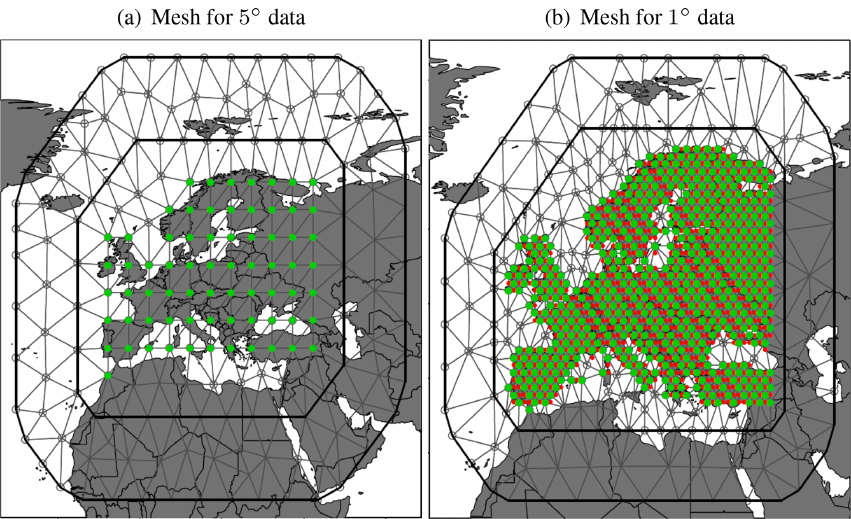
Figure 1. The triangular meshes used in our full European domain analyses for data on a 5 ◦ grid (a) and data on a 1 ◦ grid (b) . Data locations are indicated by red dots; those coinciding with mesh vertices are superimposed in